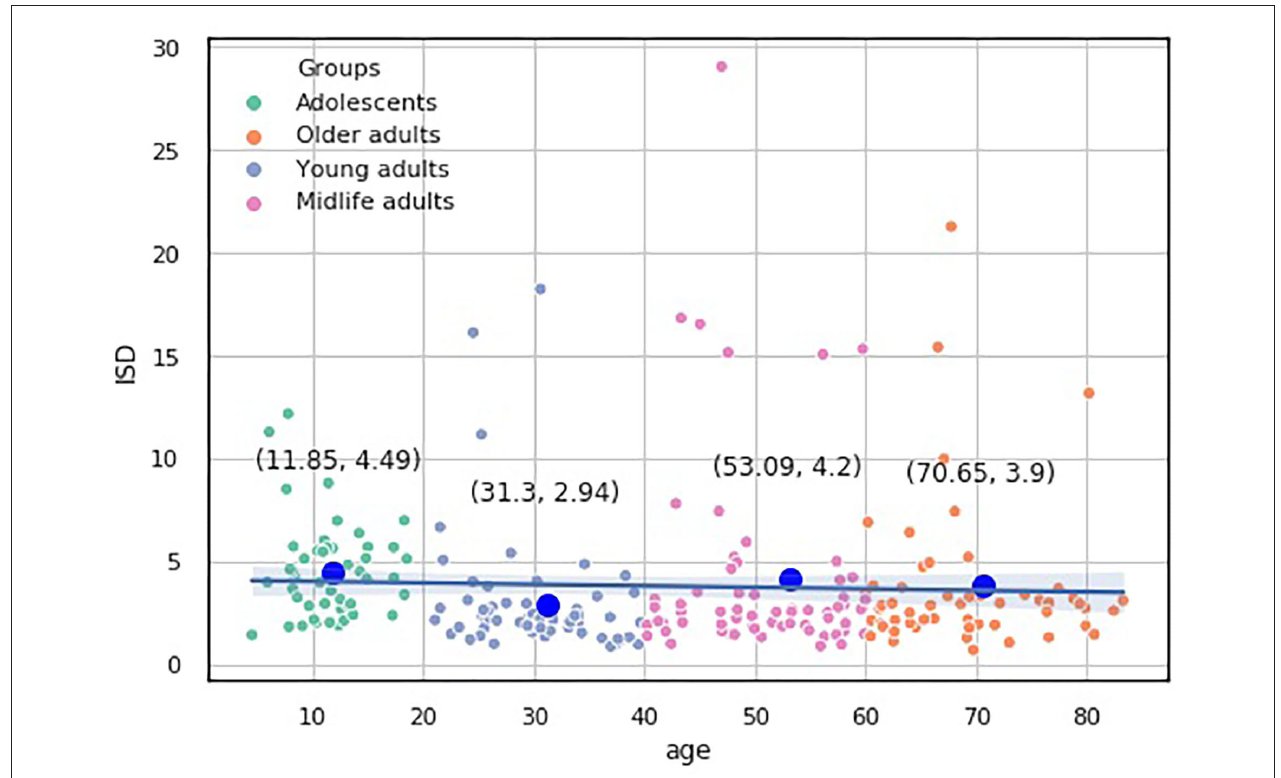
FIGURE 10 | Over-the-age distribution of ISD